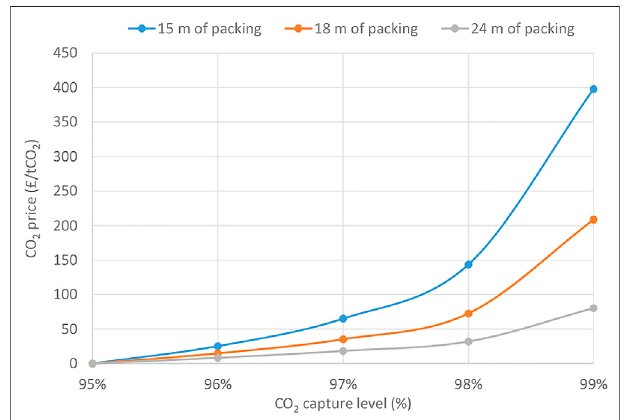
FIGURE14| Break-evenCO2emissionpriceforacapturelevelincrease from 95% based on operating costs and revenues, assuming an electricity export price of £100/MWh, at packing heights of 15, 18, and 24 m (based on marginal operating costs, so investment costs to allow this increase, including the likely need to increase the stripper diameter for 15 and 18 m of packing at the higher capture levels, are not